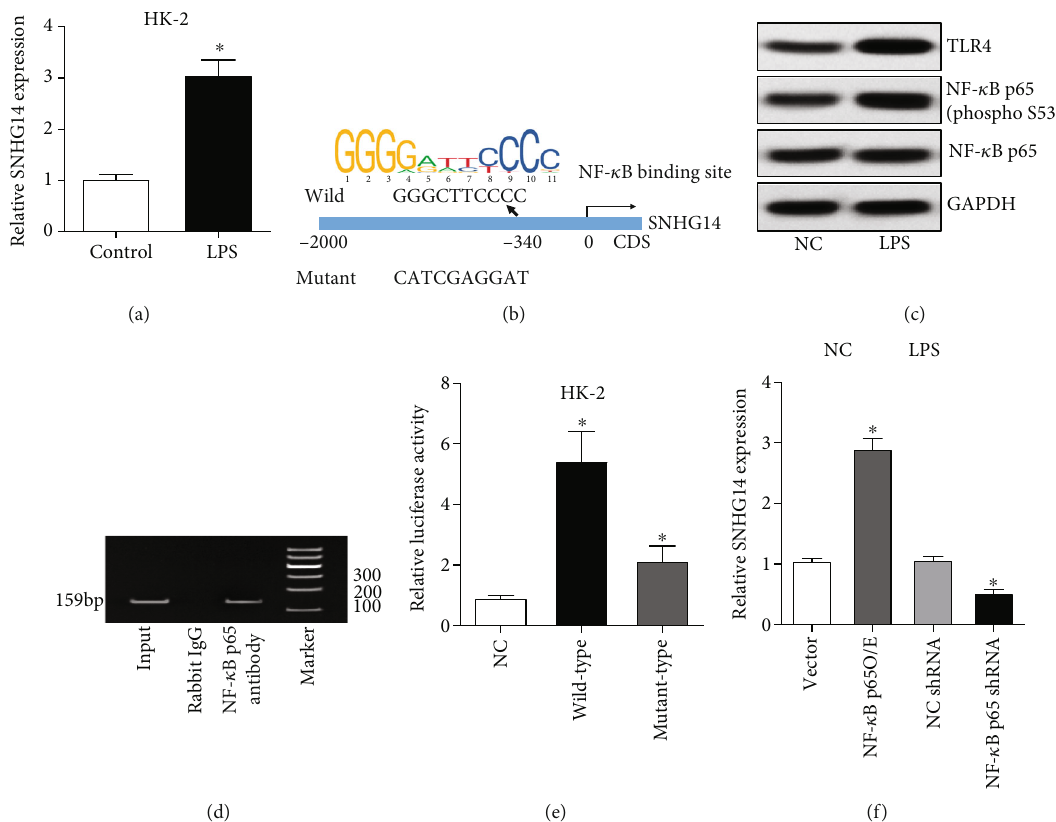
Figure 1: Increased expression of SNHG14 in LPS-induced HK-2 cells is due to the activation of the TLR4/NF- κ B pathway. (a) Expression level of SNHG14 in LPS-treated HK-2 cells. (b) Predicted binding site of NF- κ B in the SHNG14 promoter. (c) Activation of the TLR4/NF- κ B pathway in LPS-induced HK-2 cells. (d) ChIP assay showed NF- κ B bound to the SNHG14 promoter. (e) Luciferase assays showed that overexpressing NF- κ B p65 increased the activity of luciferase reporter containing a wild-type SNHG14 promoter. (f) SNHG14 levels in LPS-induced HK-2 cells transfected with NF- κ B p65 overexpression plasmids or shRNAs. Data were shown as mean ± SD , ∗ P < 0 : 05